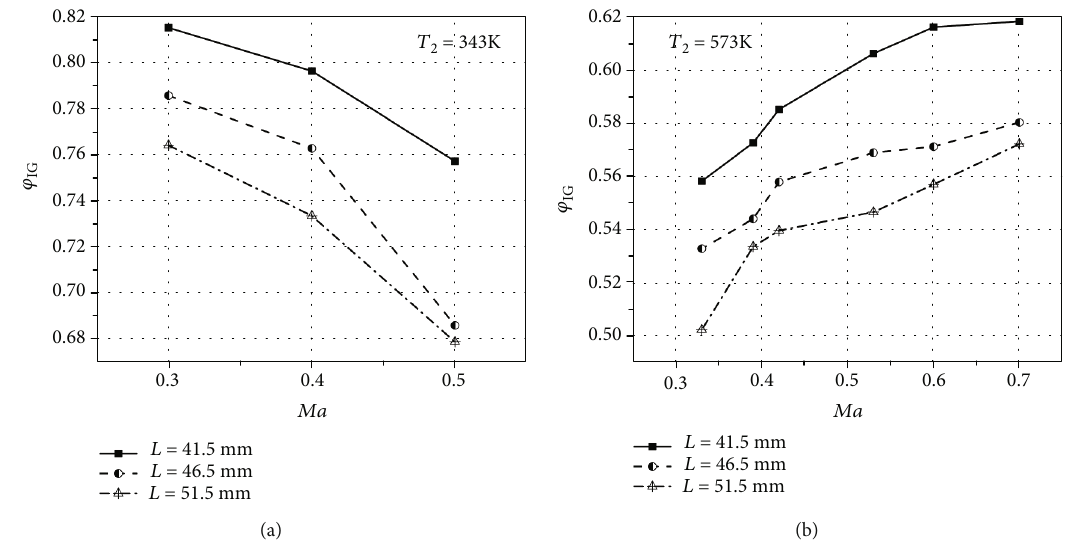
= 343 K , (b) T = 573K . 2 2